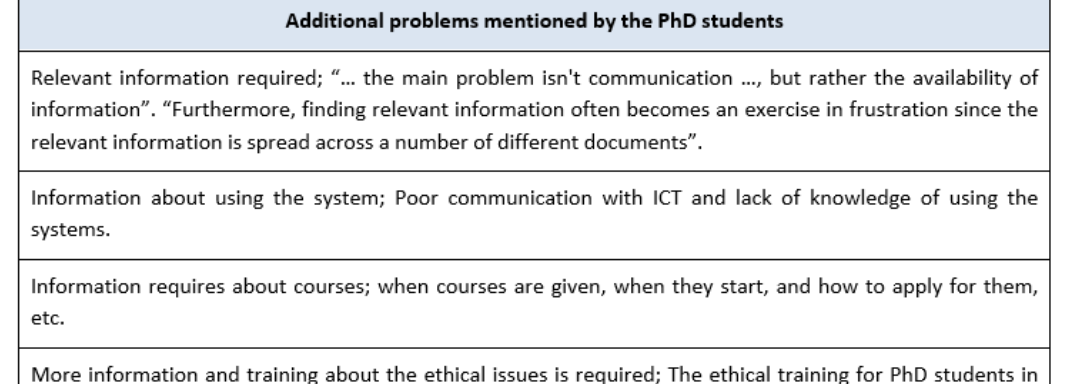
Result of the Open-Ended Questions Regarding the PhD Students’ Perspectives on the Additional Problems